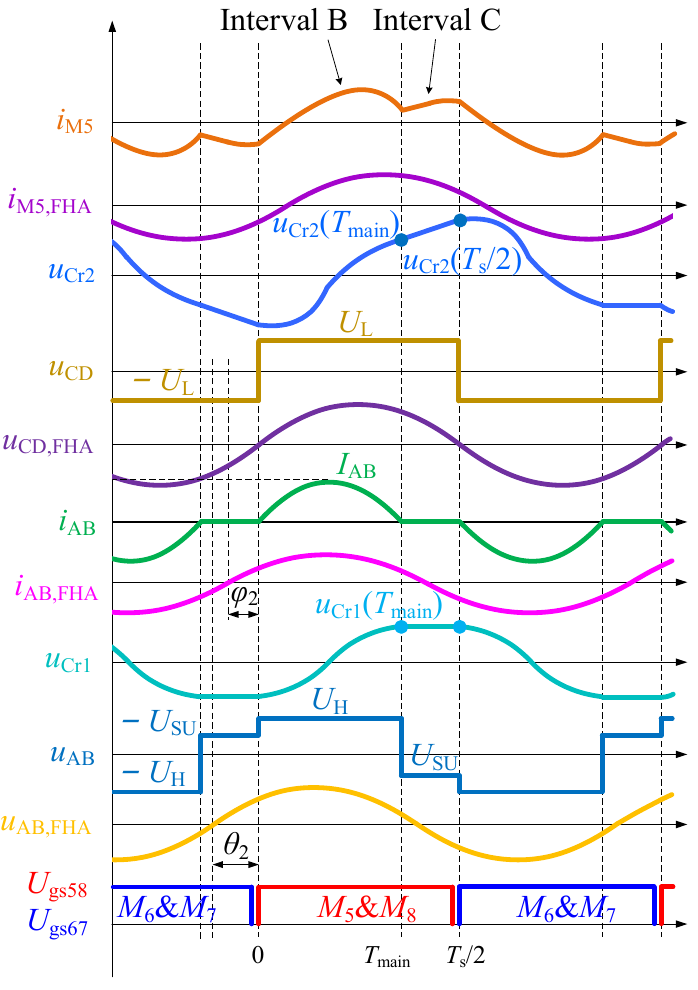
Figure 12. Waveforms in step-up mode. The output voltage of the resonant tank in T main , U SU , is shown in List 3 of the Appendix